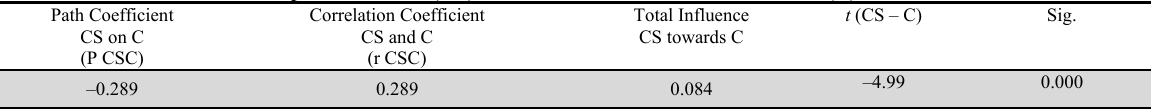
Statistical Measurements of Capital Structure (CS) Decisions’ Influence on Share Price (C) Path Coefficient CS on